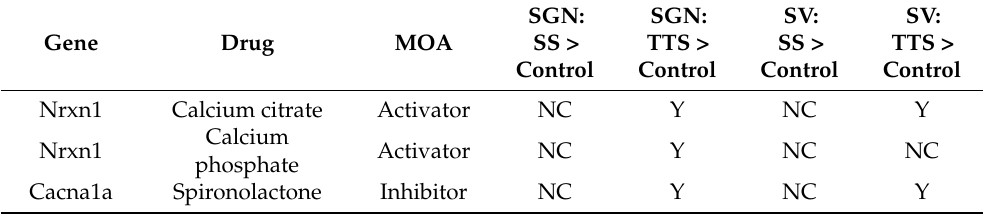
Table 7. FDA approved, orally administered drugs that modulate ions including calcium channel blockers and spironolactone that interact with steroid-responsive genes in the cochlea localized to SGN and SV cell types.